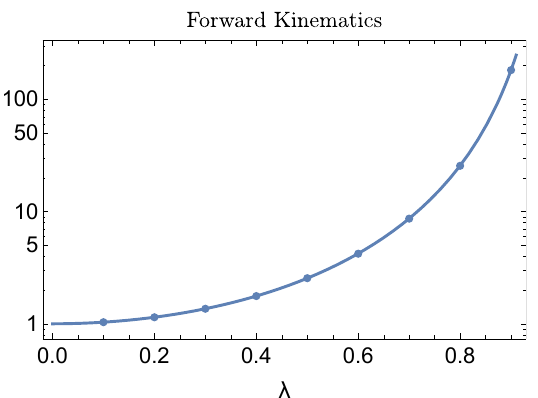
| p | N O qf ( q i ) conn (vertical axis) i π 4 h i − Q